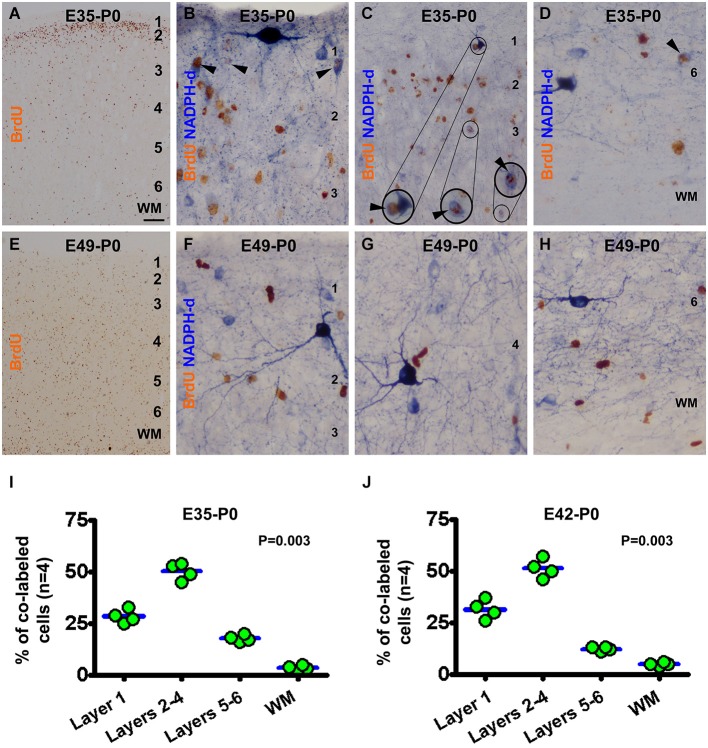
Representative images and laminar analyses illustrating bromodeoxyuridine (BrdU) and BrdU/NADPH-d labeling in neonatal guinea pig neocortex following pulse-chasing at embryonic day 35 (E35, A–D), E42 (J, images not shown) and E49 (E–H). BrdU immunoreactive cells are predominately localized to layer 2 in the E35-P0 group (A), but occur across the cortex without apparent laminar preference in the E49-P0 group (E). BrdU/NADPH-d double-labeled neurons (pointed by arrowheads and enlargements in B-D) are differentially distributed among the laminar sectors (P = 0.004), mostly dense in layers 2–4 for both the E35-P0 (I) and the E42-P0 (J) groups. No BrdU/NADPH-d double-labeled neurons are found in the E49-P0 group (E–H). Scale bar = 100 μm in (A) applying to (E), equivalent to 20 μm for (C) and 10 μm for the remaining image panels.